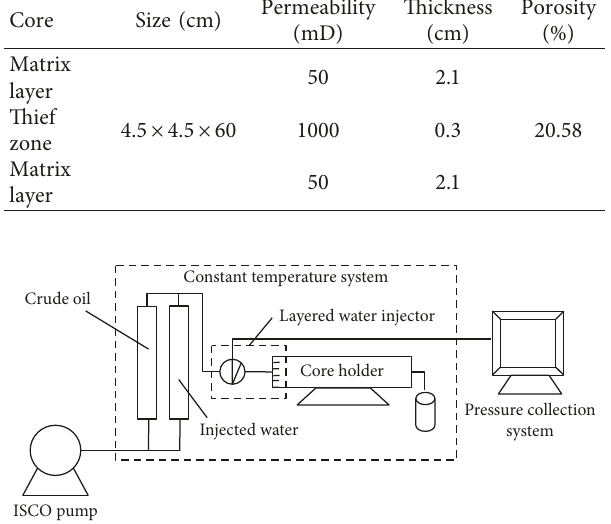
Figure 3: Experimental